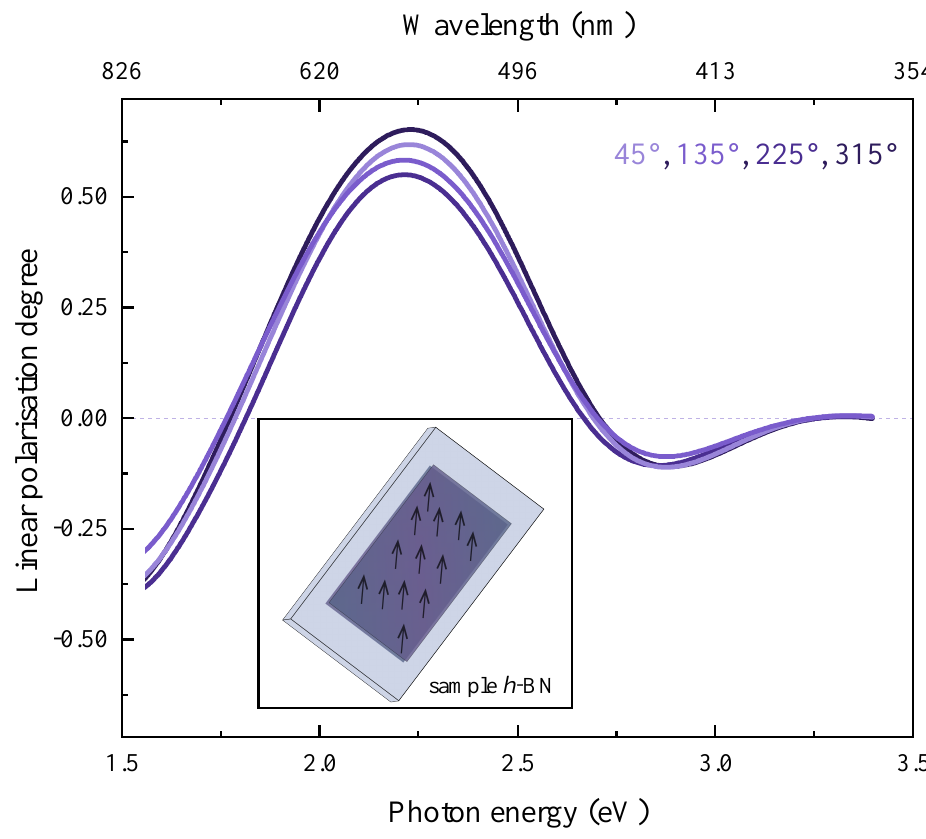
Figure 4. Spectral dependencies of the linear polarisation degree P lin at selected azimuthal angles for linearly polarised light passed through the sample. Spectra were obtained at room temperature. The inset shows the direction of the optical axis over the entire area of the